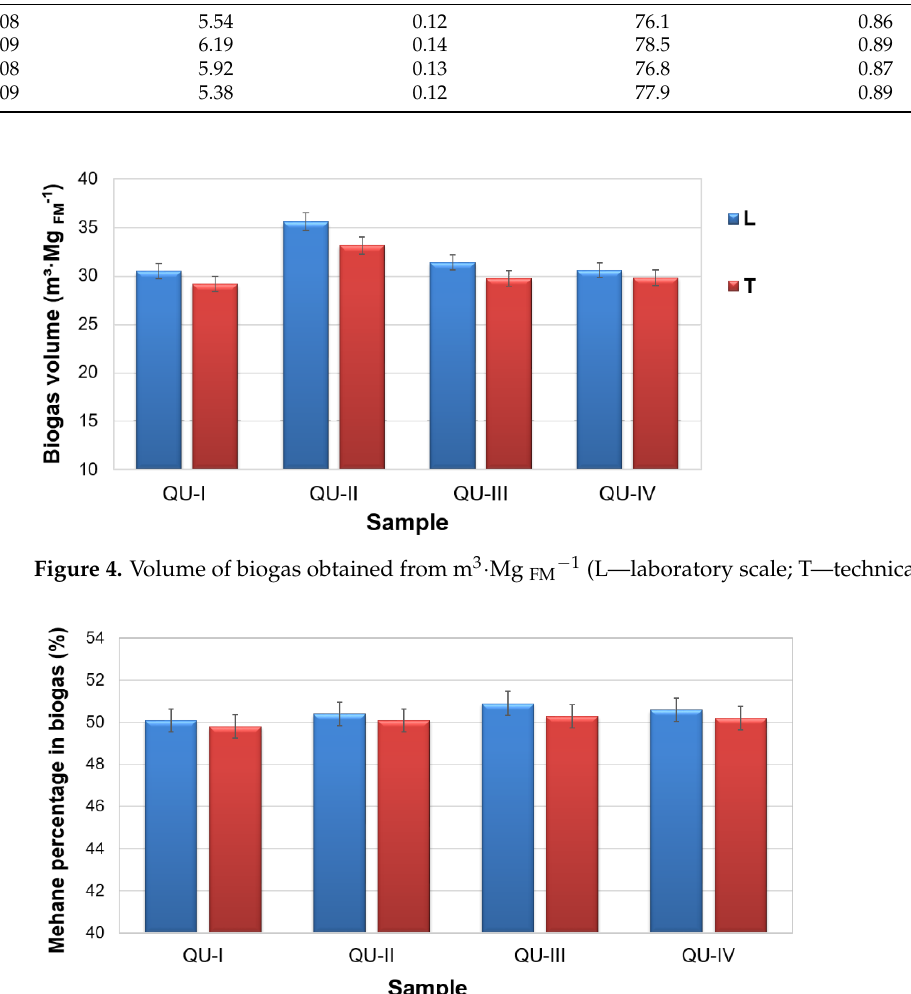
Figure 5. Methane percentage in biogas (L—laboratory scale; T—technical scale).